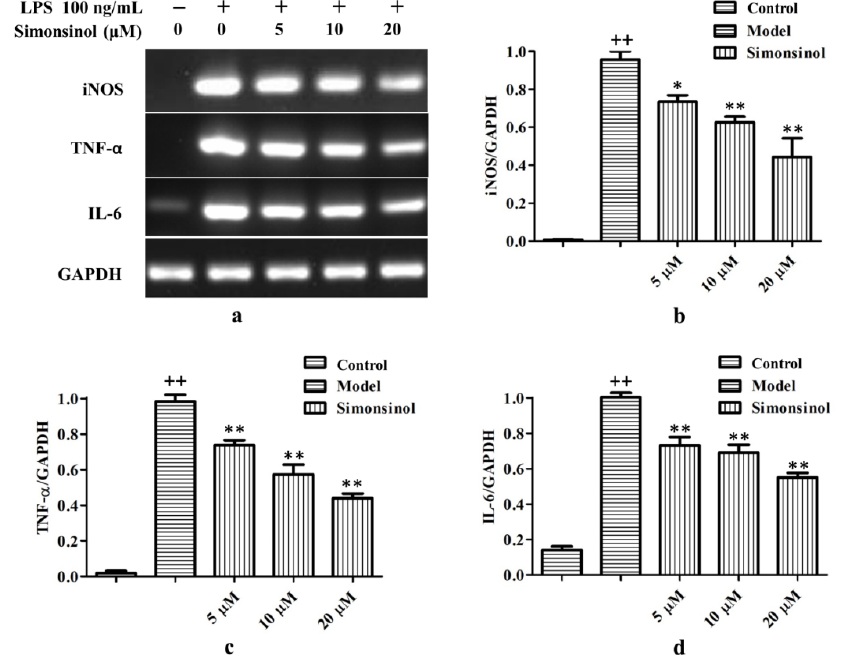
Figure 5. Simonsinol dose dependently suppresses transcription of iNOS, TNF-α, and IL-6 mRNA in LPS-stimulated RAW264.7 cells. ( a ) Representative result of PCR. ( b ) Relative expression of iNOS mRNA. ( c ) Relative expression of TNF-α mRNA. ( d ) Relative expression of IL-6 mRNA. Data are represented as the mean ± SD (n = 3). ++ , highly significant difference compared to blank control cells ( p < 0.01). *, significant difference compared to LPS-stimulated model cells ( p < 0.05). **, highly significant difference compared to LPS-stimulated model cells ( p < 0.01).